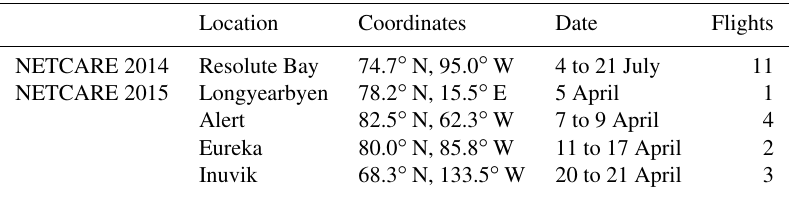
Table 1. Locations and coordinates for the different stations from which measurement flights were performed during the two NETCARE airborne projects in July 2014 and April 2015. Additionally, the time at the station and the number of research flights are